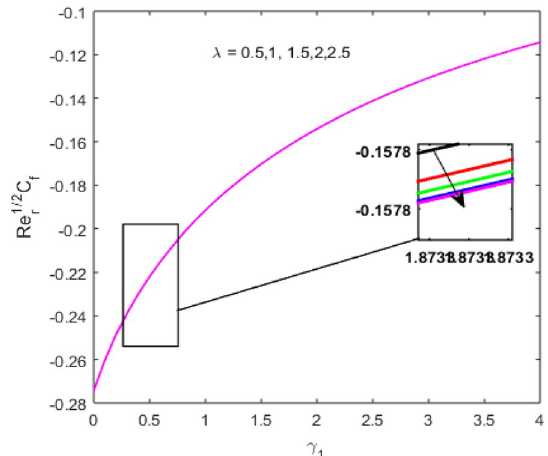
Figure 5. ( Re r ) 1 / 2 C f versus γ 1 for varying (cid:31) .